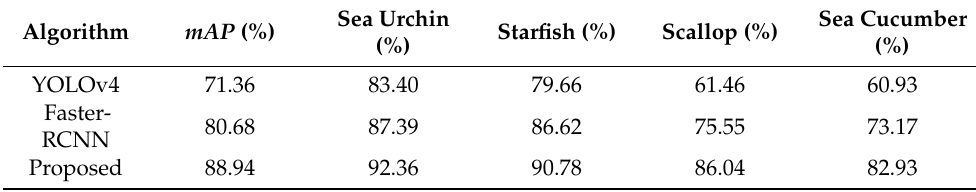
Table 4. Comparison of different detection models on the URPC2018